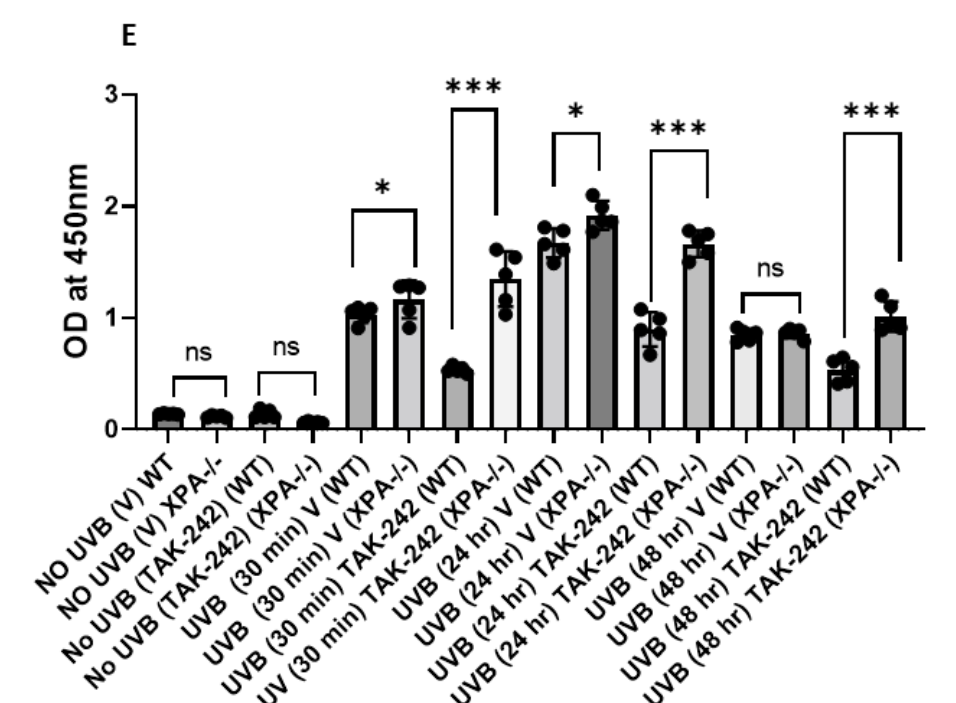
Figure 1. TLR4 inhibitor TAK-242 enhances the repair of UVB-induced CPDs. SKH-1 mice were exposed to a single dose of UVB radiation (100 mJ/cm 2 ), and were thereafter sacrificed at different time points. Mice not exposed to UVB were used as controls. ( A ) DNA was also isolated from skin and subjected to ELISA for CPDs. There were fewer CPDs in the skin of TAK-242 treated WT mice. ( B ) Skin samples were also analyzed for expression of XPA mRNA. Expression of XPA mRNA was significantly higher in the skin of TAK-242 treated mice in comparison to vehicle-treated mice. ( C ) The Expression of XPA were further confirmed by Western blot assay. There was significantly higher expression of XPA protein in the skin of TAK-242 treated mice. ( D ) Panels of XPA − / − and WT (C57BL/6) mice were exposed to a single dose of UVB (100 mJ/cm 2 for WT and 20 mJ/cm 2 for XPA − / − ) radiation. Formalin fixed skin sections (5 µM thick) were subjected to immunoperoxidase staining to detect CPD+ cells that stained brown. There were significantly fewer CPDs at 24 h in the skin of TAK-242 treated mice. CPD+ cells were not detected in non-UVB- exposed skin. There was no significant reduction in CPDs in the skin of XPA − / − mice. Magnification ×40. Summary of CPD+ cells. The number of CPD+ cells were counted in five to six different areas of the sections under an Olympus BX41 microscope. The numbers reported represent the CPD+ cells ± SD in epidermis. Scale bar = 50 µM. ( E ) DNA was also isolated from skin at 30 min, 24 h, and 48 h post-UVB exposure and subjected to ELISA for CPDs. There were fewer CPDs in the skin of TAK-242 treated WT mice. There was significant reduction in CPDs in WT mice treated with TAK-242. Experiments were conducted and repeated separately in 5 mice in each group with identical results. (* p < 0.05 and *** p < 0.001 and ns, not significant). The whole western blot figures of